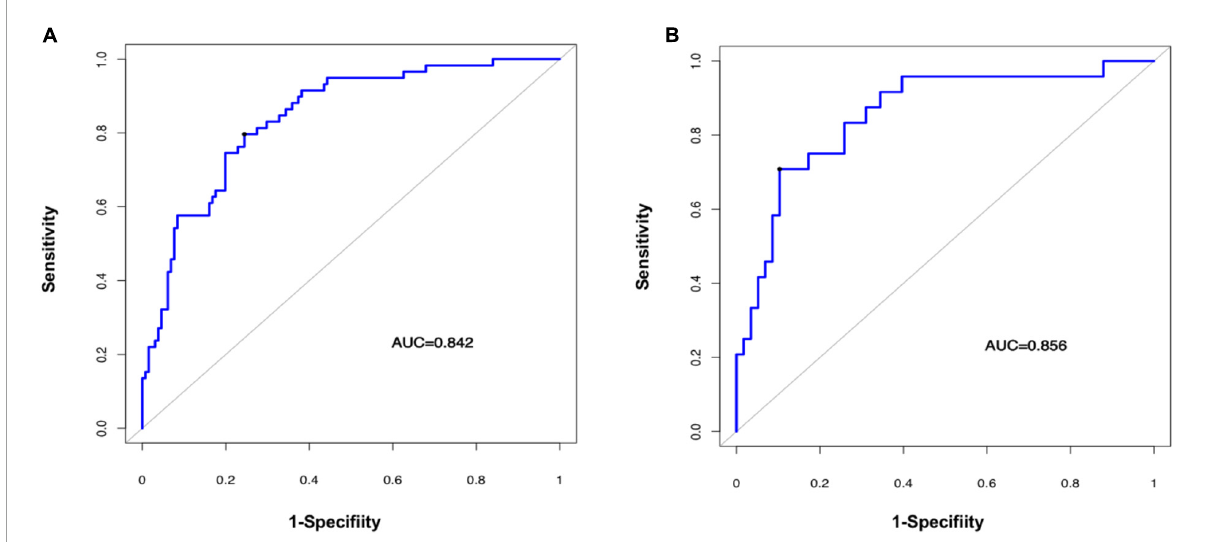
FIGURE3 Evaluating the accuracy of the radiomic signature. Prediction of a high risk of fSAD using the radiomic signature in the training cohort (A) (AUC = 0.842) and in the validation cohort (B) (AUC = 0.856). AUC, area under the receiver-operator characteristic (ROC) curve; fSAD, small airway dysfunction.